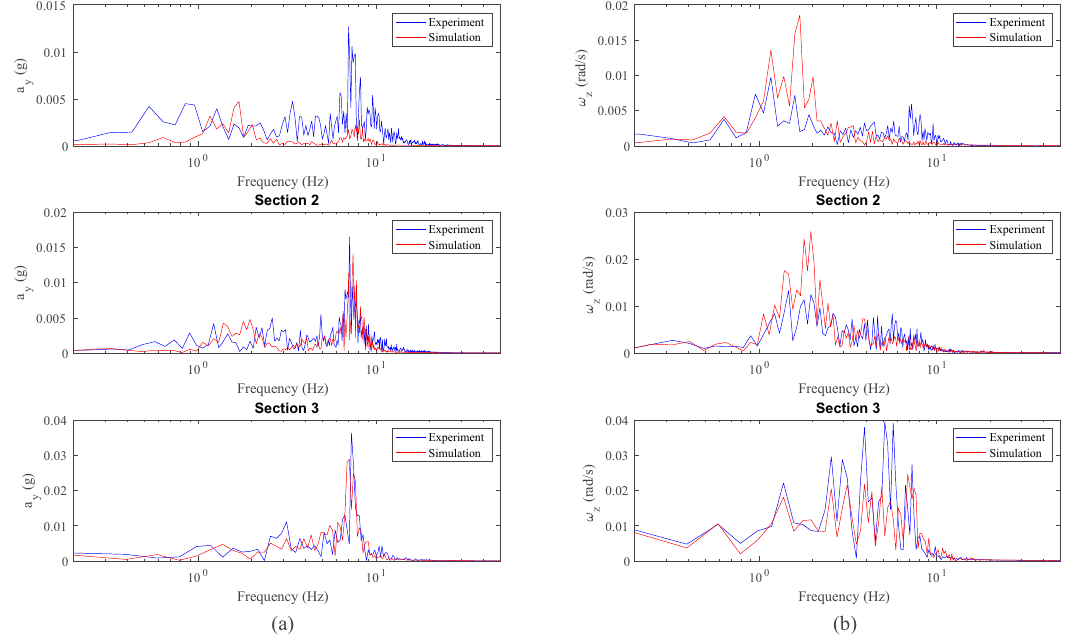
Figure 20. Frequency analysis of lateral acceleration ( a ) and yaw angular velocity ( b ) data from inertial sensors on the bogie